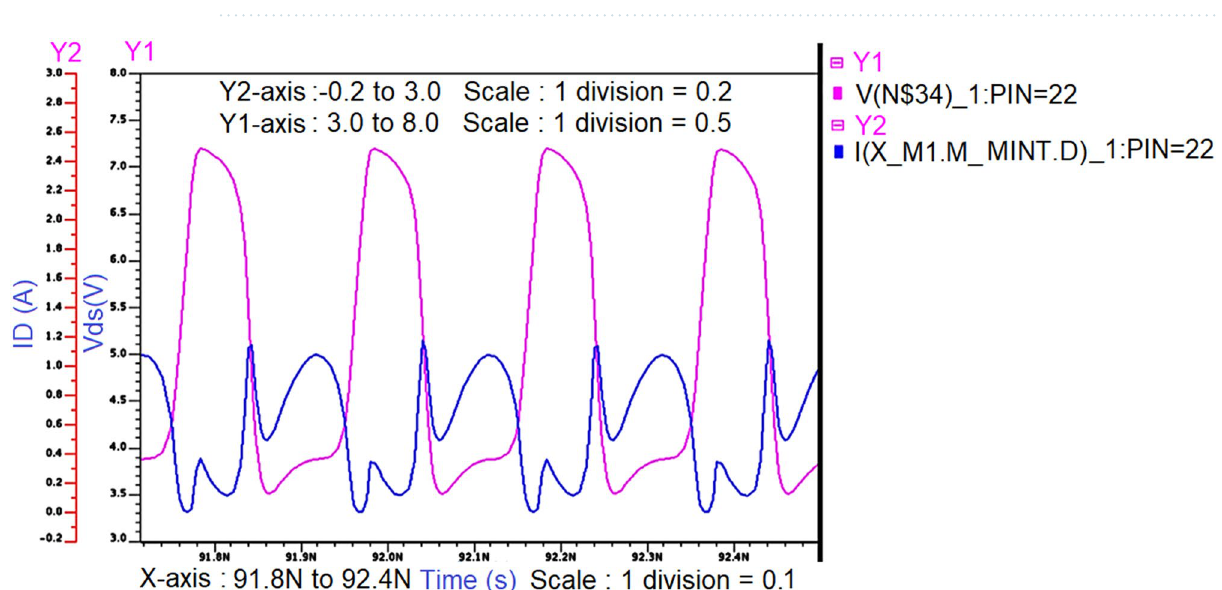
Figure 15. Intrinsic voltage and current waveforms at the drain of proposed Class-J PA (V DS and I D ) with Fourier input source at 5